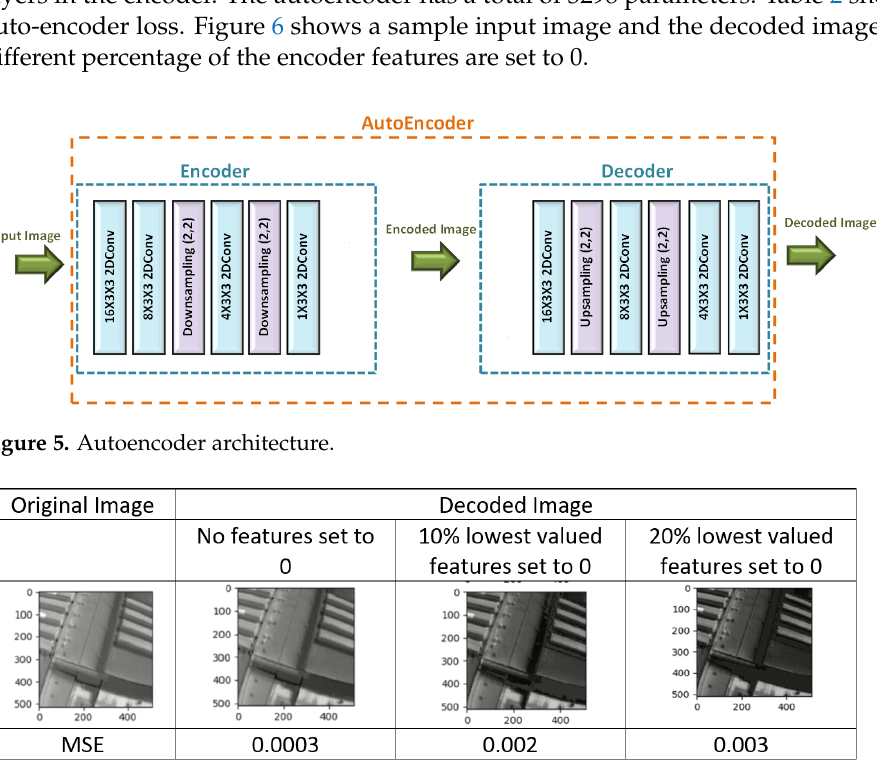
Figure 6. Original and decoded images when different percentages of encoder output is set to zeros. Table 2. AutoEncoder Losses on a core i7-4790 @ 3.6 GHz